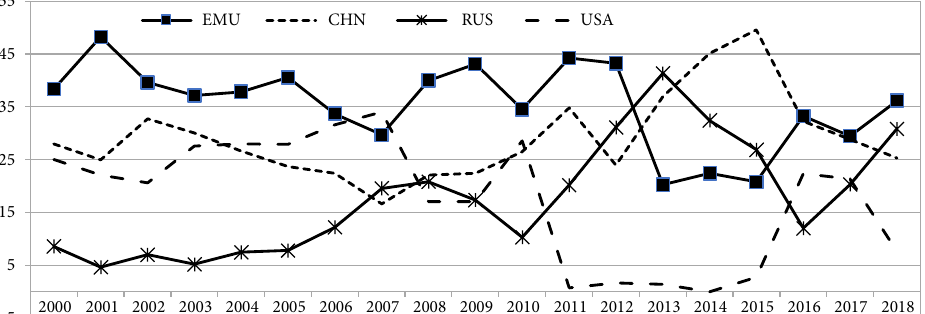
Figure 4. Relative Grubel and Lloyd index during 2000–2018 (source: own research based on UNCTAD,